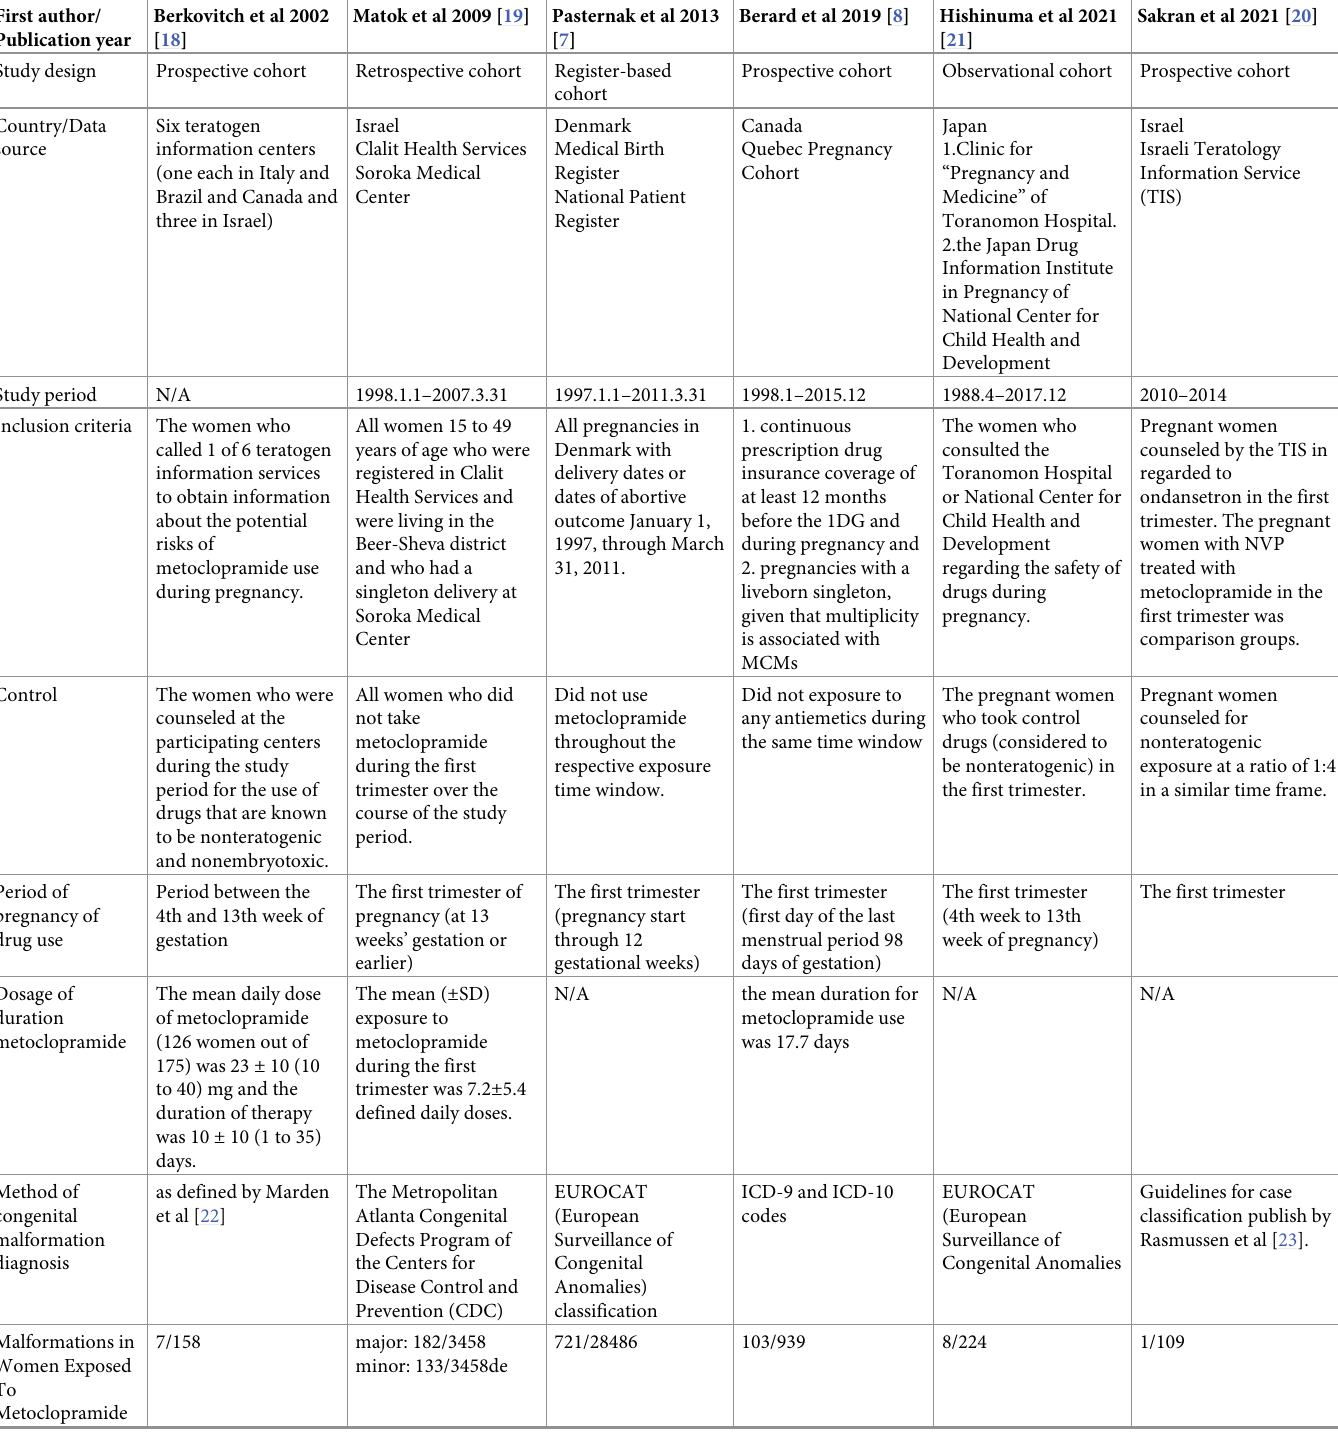
Table 1. Characteristics of included studies in this